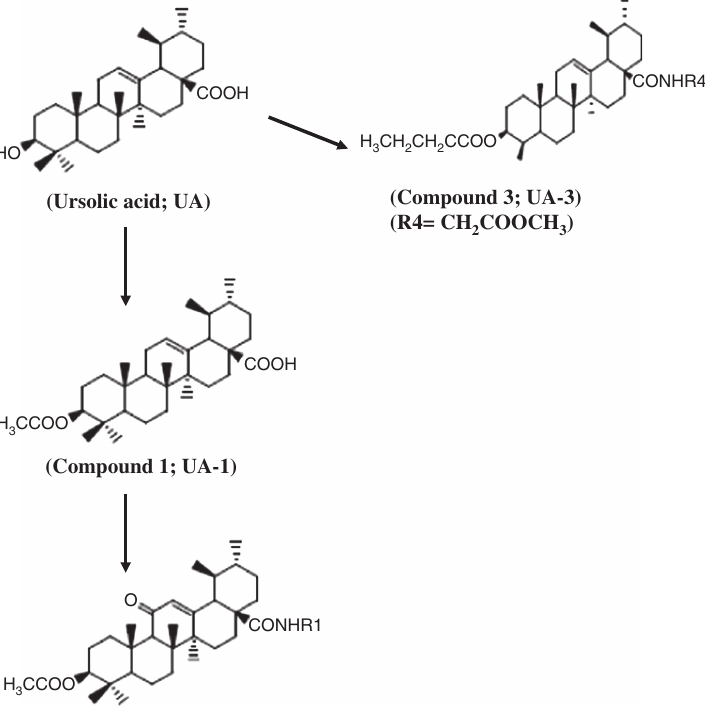
O, DMAP, THF, 2 N, NH R1, R.T. 3 2